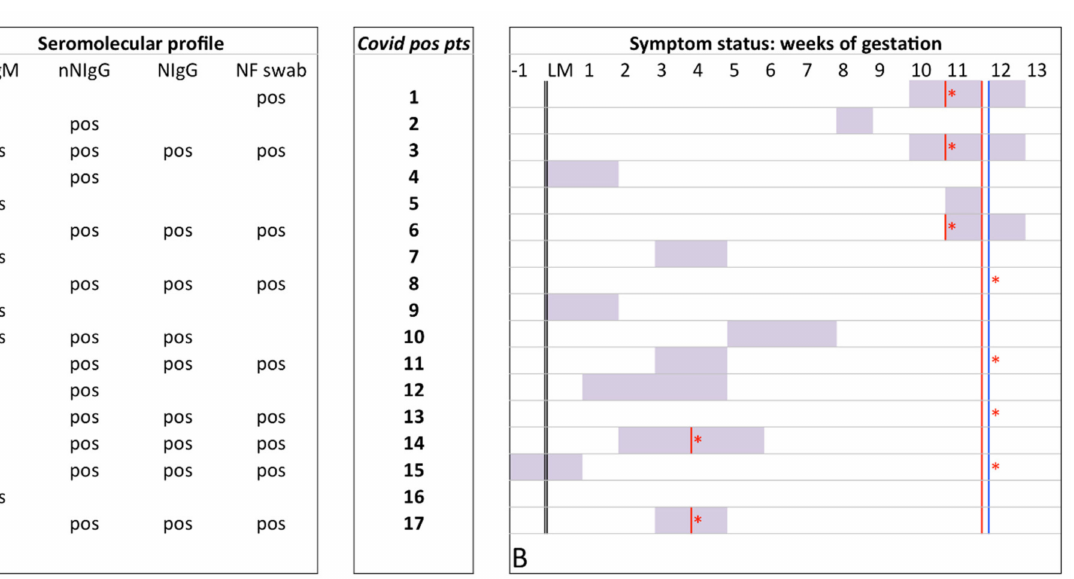
Figure 2. COVID-19 affected patients: seromolecular profile ( A ) and symptom status ( B ). Blue vertical line, serological sampling; NIgG, neutralizing IgG; nNIgG, non-neutralizing IgG; nNIgM, non-neutralizing IgM; NF, nasopharyngeal; pos, positive; pts, patients; purple box, time window of symptoms; red vertical line, molecular sampling; red *, molecular positive